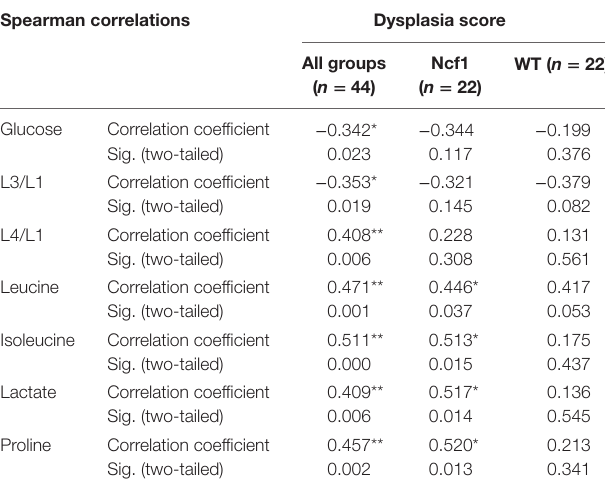
TaBle 4 | Summary of all statistically significant Spearman correlations for weight variation vs metabolites concentrations considering either all mice pooled